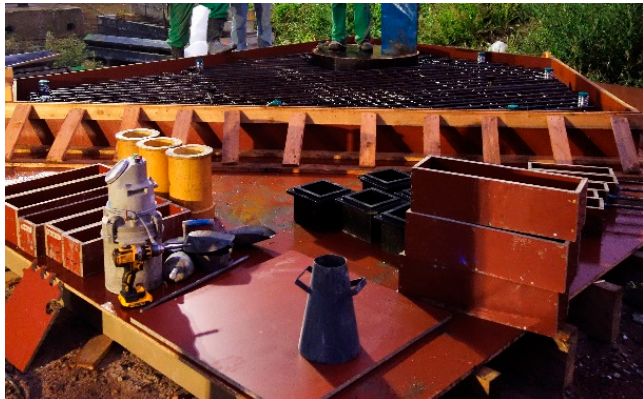
Figure 1. Formwork of the roof slab with the molds of the accompanying lab specimens in front.